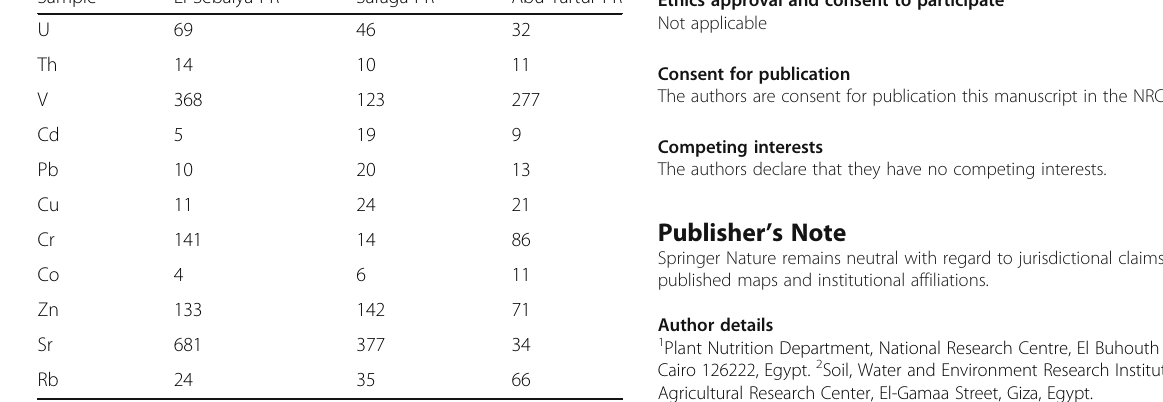
Table 6 Trace elements (mg kg − 1 ) contents of phosphate rock